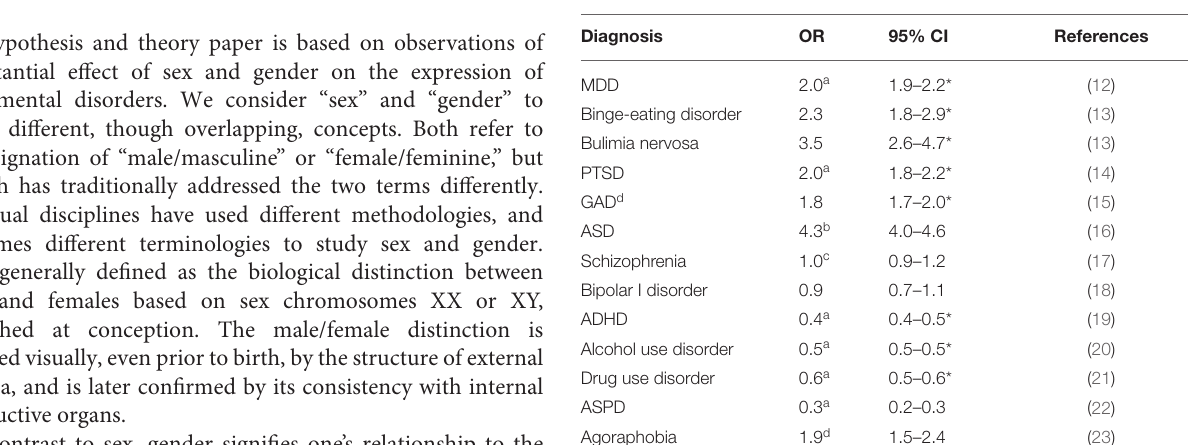
TABLE 1 | F:M sex differences across mental